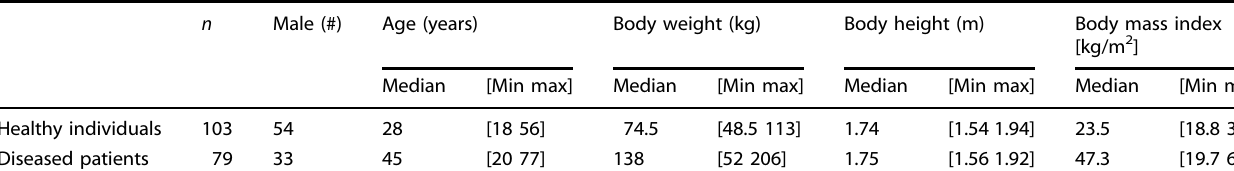
Table 1. Summary of statistics for anthropometrical parameters in both populations